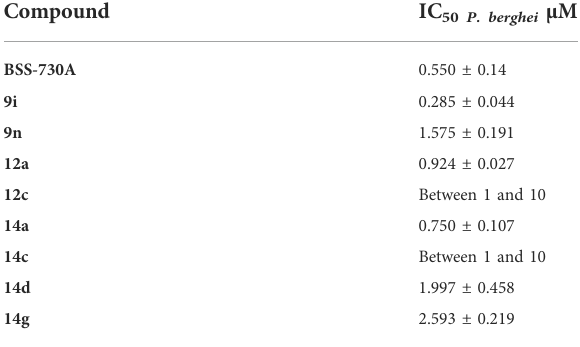
TABLE 6 Compound activity against the P. berghei hepatic stage.